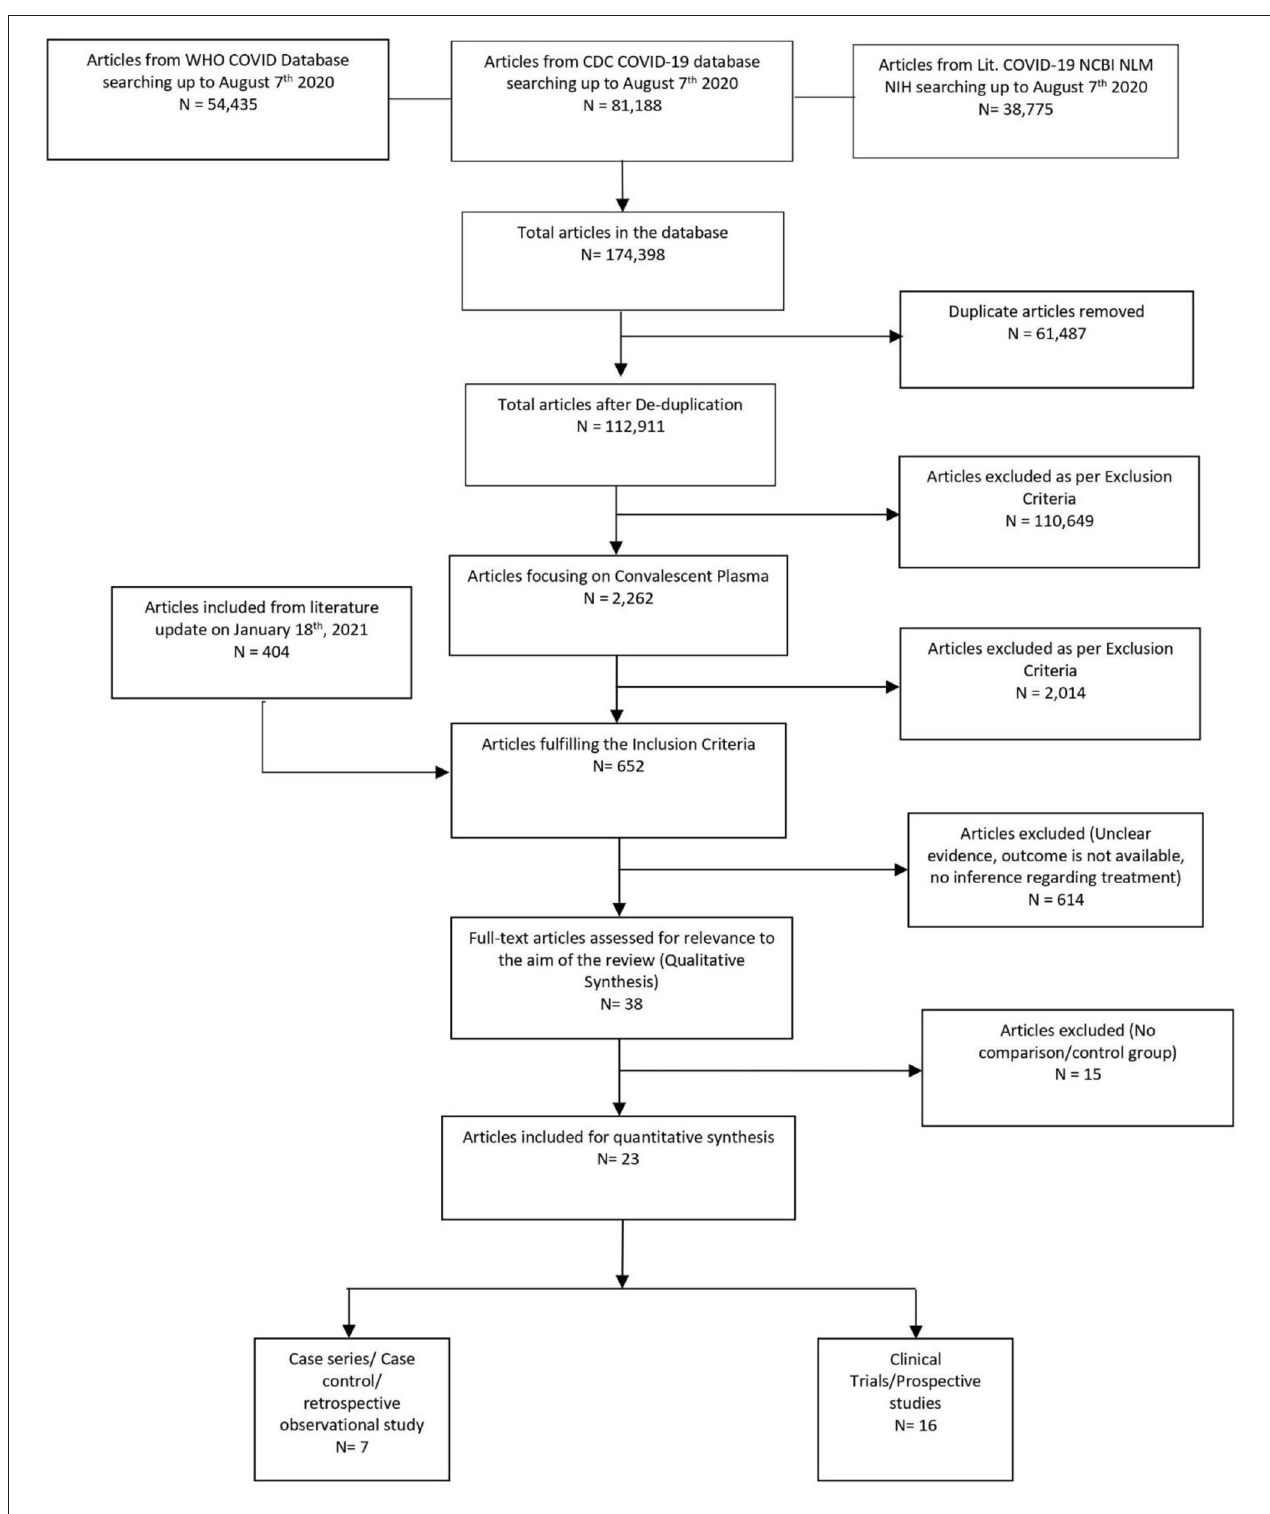
FIGURE 1 | PRISMA study flow